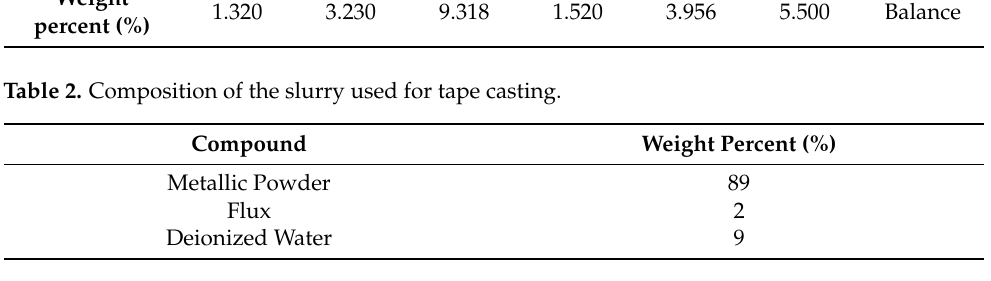
Table 3. Chemical composition of the steel substrate. Element